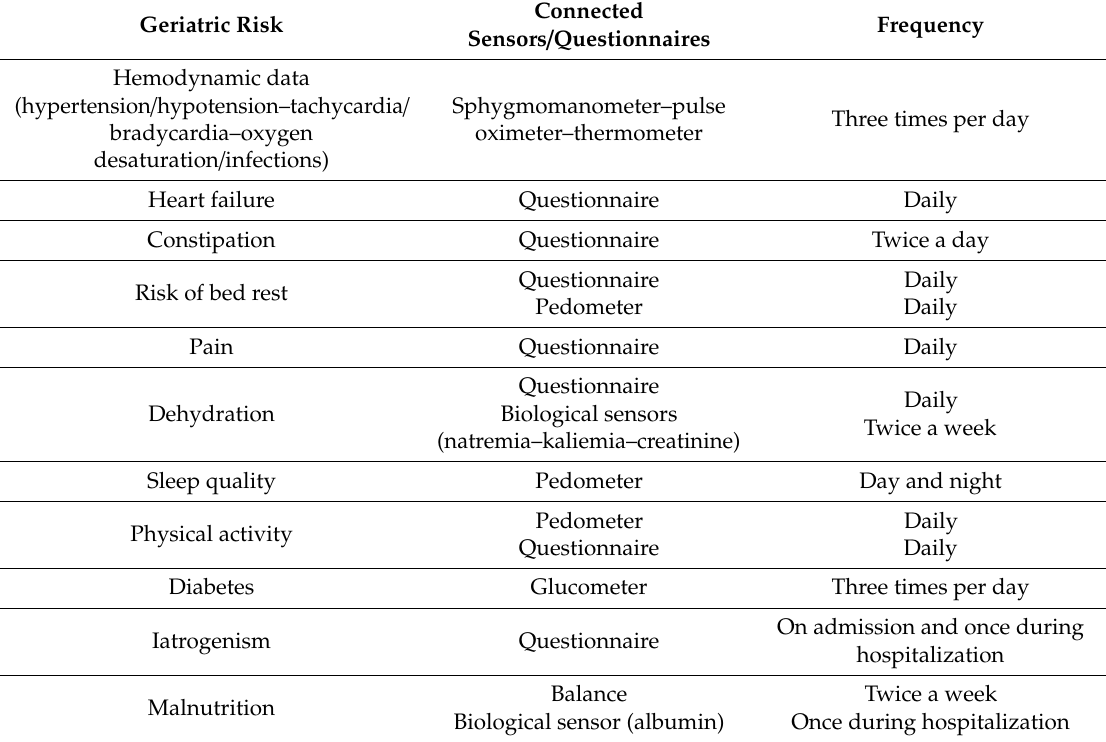
Table 1. Remote monitoring of geriatric risks in the GER-e-TEC study.